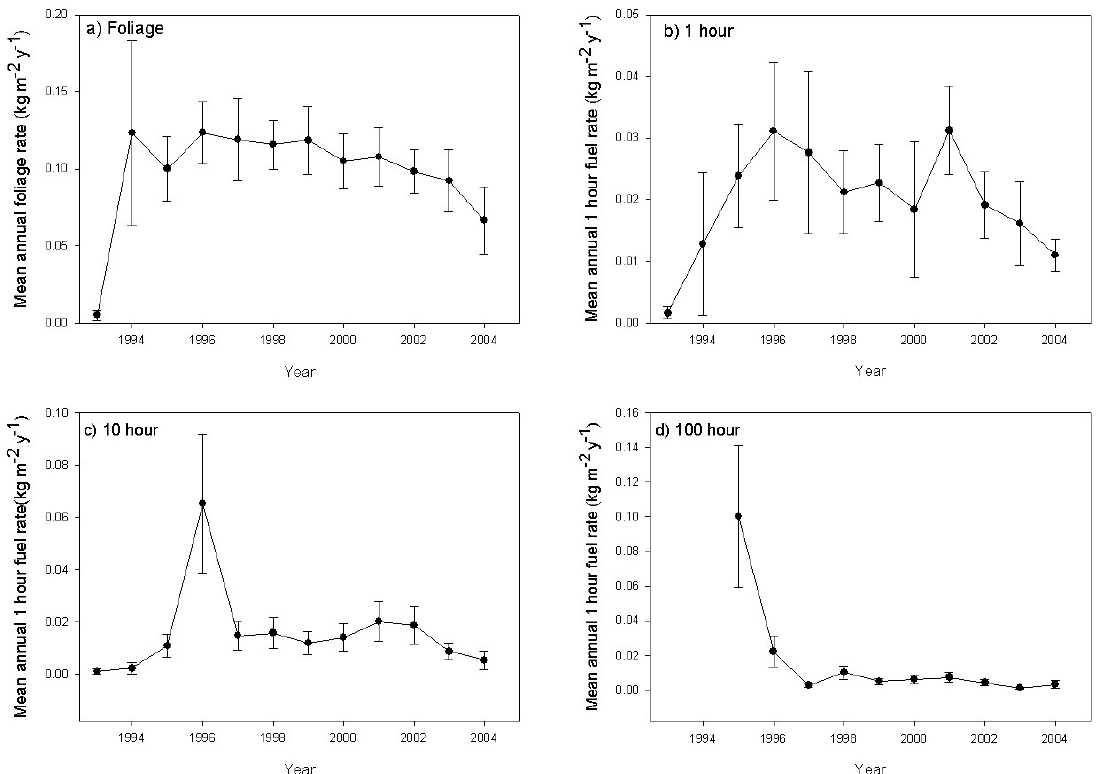
Figure 6. Coarser fuels have higher interannual variability. The amount of deposited biomass by fuel component on the Coram site over 12 years of collection ( a ) foliage (litter); ( b ) 1 h; ( c ) 10 h; and ( d ) 100